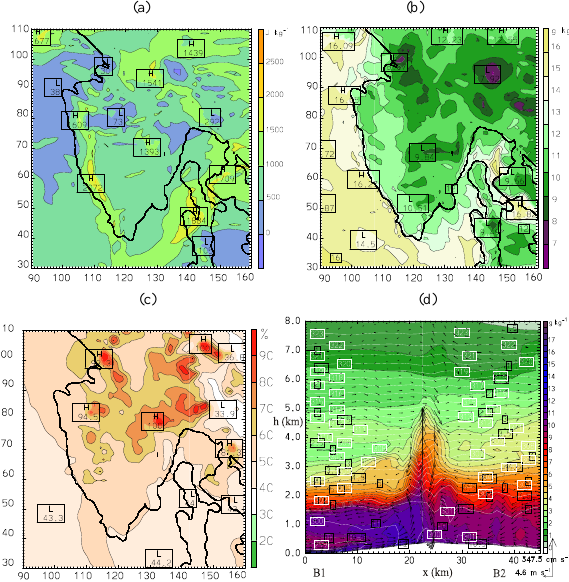
Fig. 5. Horizontal distributions on 9 July 2006 of (a) the CAPE (Jkg − 1 ) at 10:00CET that represents the potential for deep convec- tion; (b) the low-level humidity mixing ratio (gkg − 1 ) at 13:00CET; (c) the averaged relative humidity (%) in the layer between 850hPa and 500hPa at 12:00CET; (d) vertical cross-section (B1B2) (in Fig. 1a) of the potential temperature (while lines), humidity mix- ing ratio (filled areas) and wind vectors at